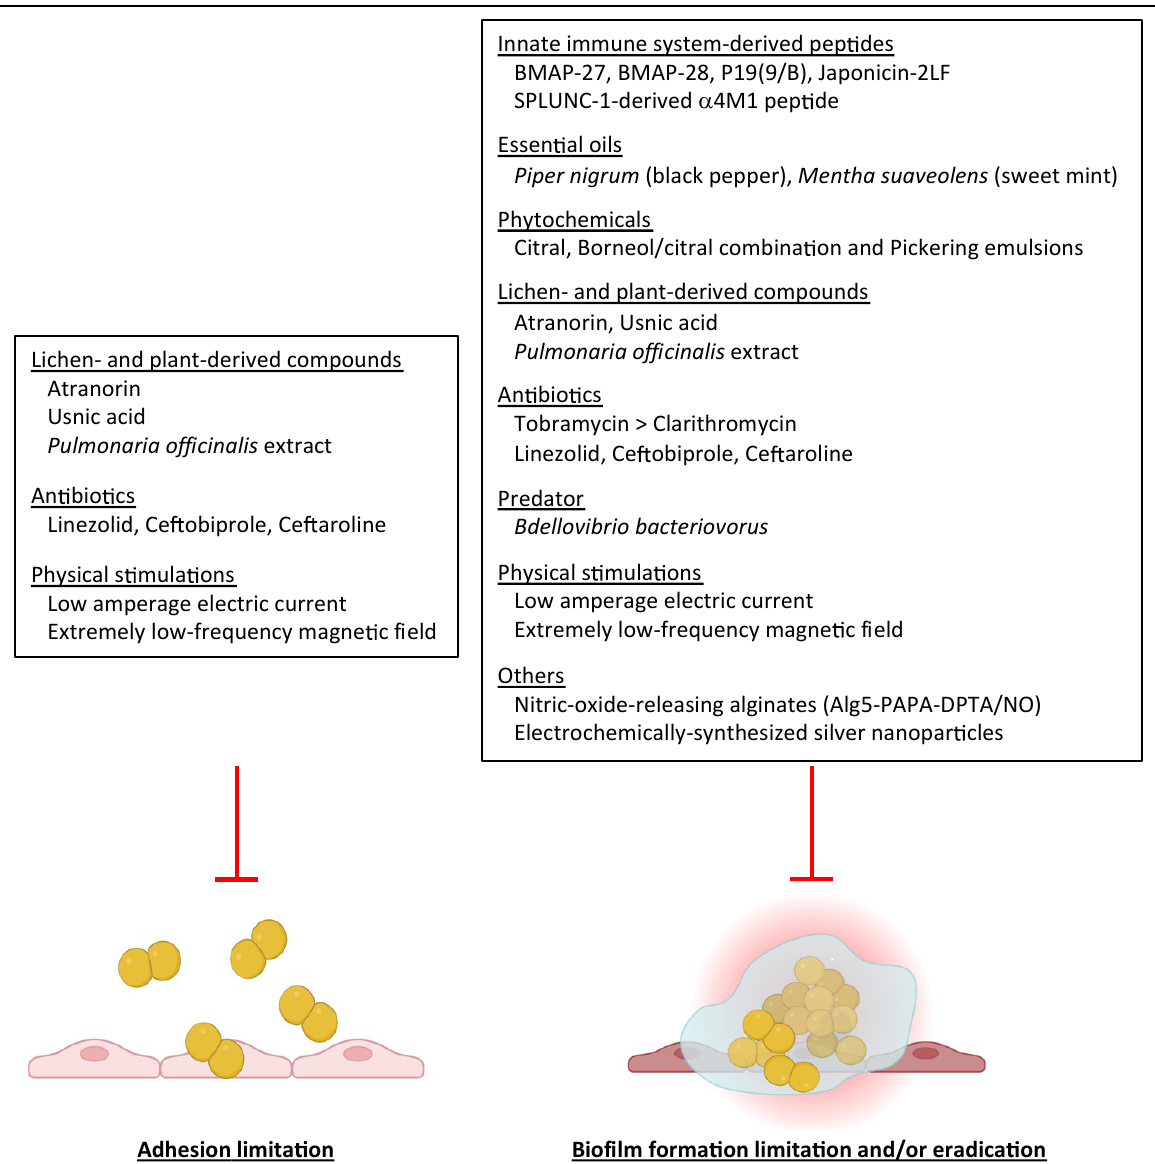
Figure 3. Presentation of anti-biofilm strategies shown to affect biofilm formation by S. aureus strains isolated from CF patients according to the two stages of biofilm formation specifically under study in the literature reviewed, i.e., adhesion and maturation/development (including biofilm formation and biofilm eradication).